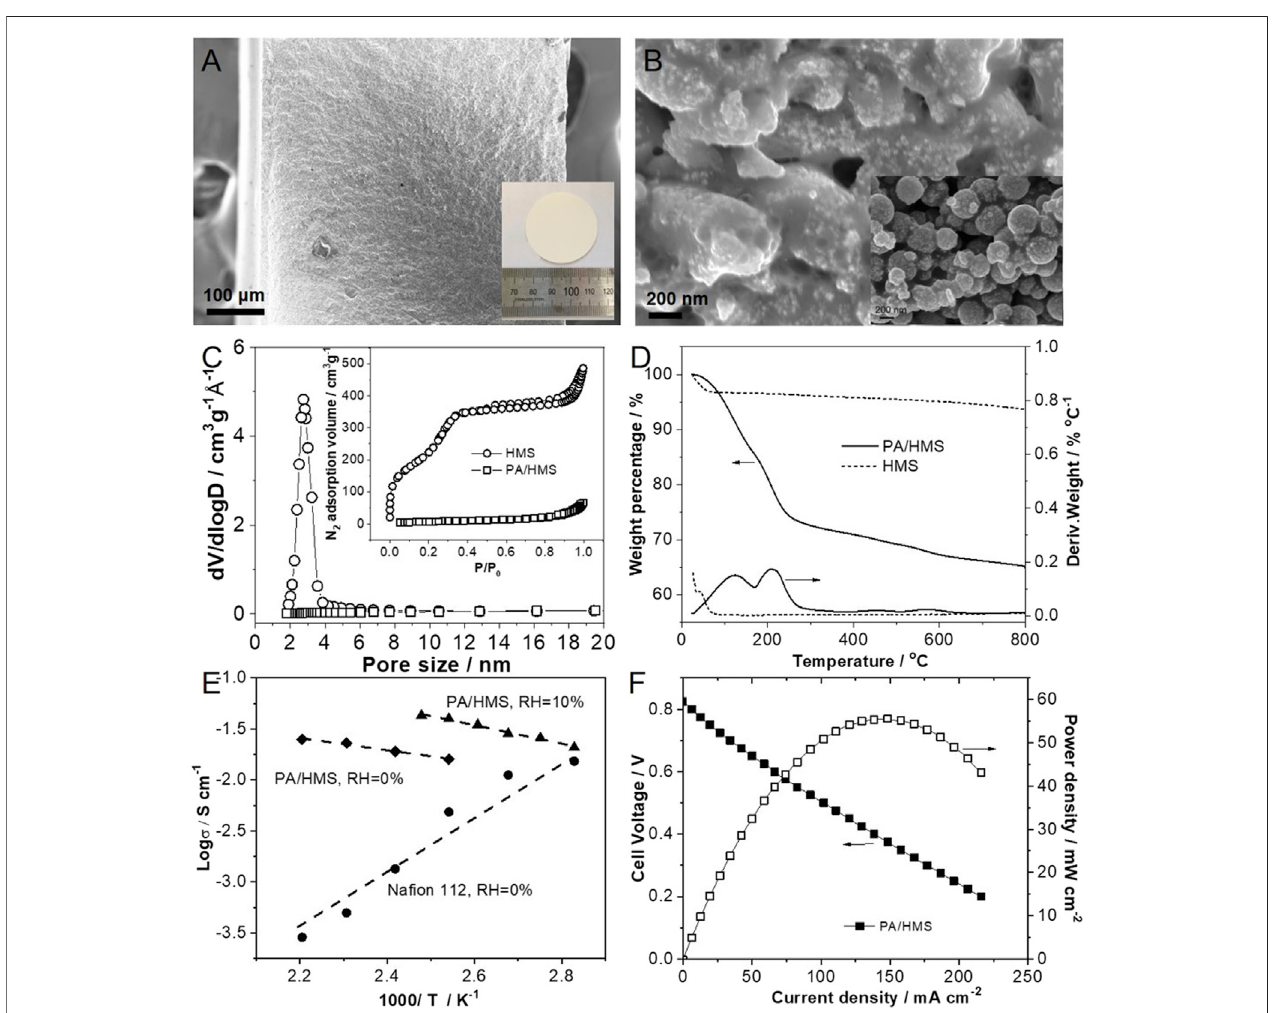
FIGURE 7 | SEM image of (A) the HMS membrane, the inset is an optical photograph of HMS membrane and (B) the PA/HMS membrane, the inset is the SEM imageofthesurfaceofpristineHMSmembrane. (C) N 2 isothermcurvesand (D) TGAcurvesofHMSandPA/HMS. (E) ProtonconductivityofPA/HMSmembraneunder different temperature and humidity conditions. The Na fi on ® 112 membrane is employed as reference. (F) Fuel cell polarization curves of PA/HMS at 160 ° C and 0%